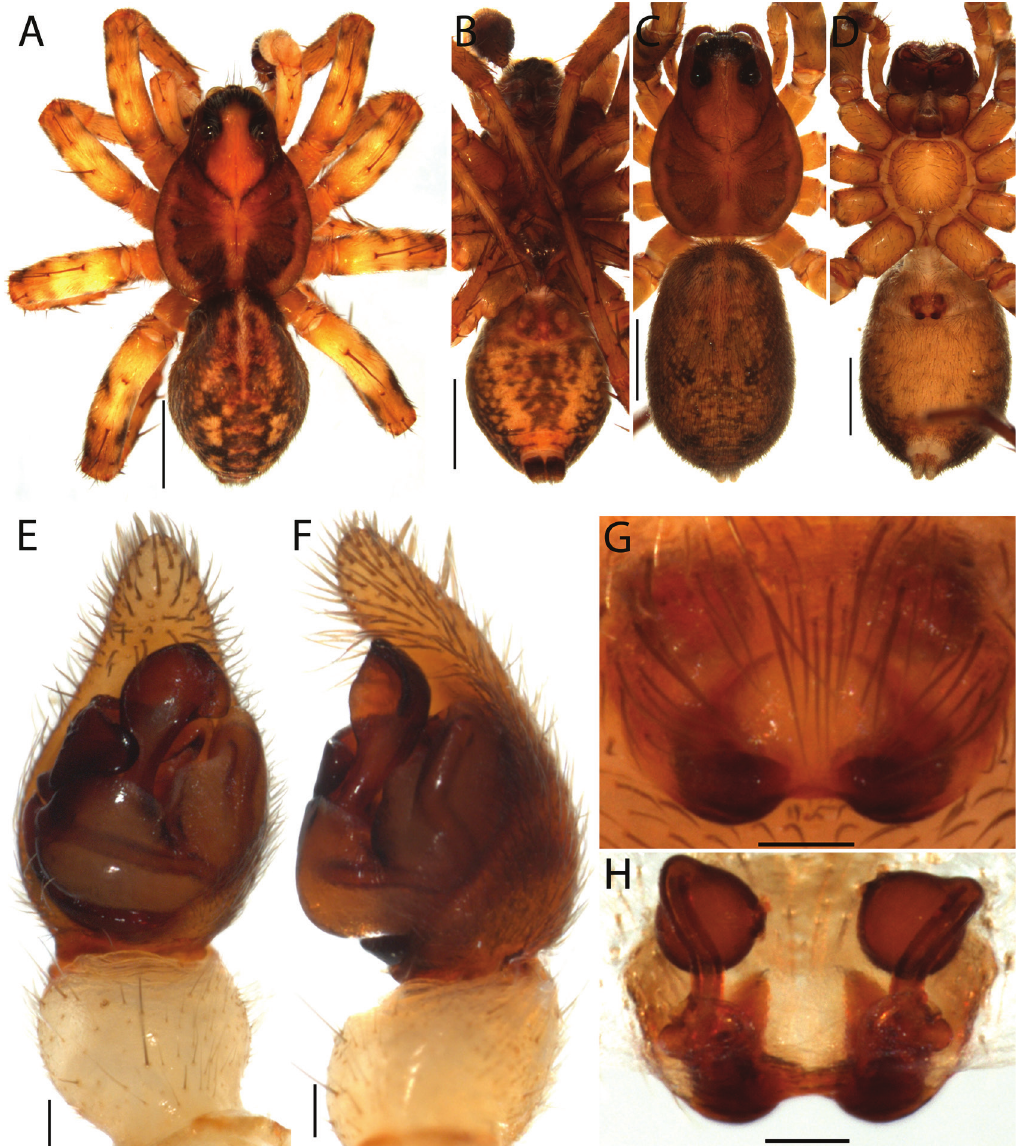
Figure 35. Artoria quadrata Framenau,2002, male (AM KS61739), female (AM KS75188): A , male habitus, dorsal view; B , male habitus, ventral view; C , female habitus, dorsal view; D , female habitus, ventral view; E, male pedipalp, ventral view; F , male pedi- palp, retrolateral view; G , epigyne, ventral view; H , epigyne, dorsal view. Scale bars: habitus 1.0 mm; pedipalp, epigyne 0.1